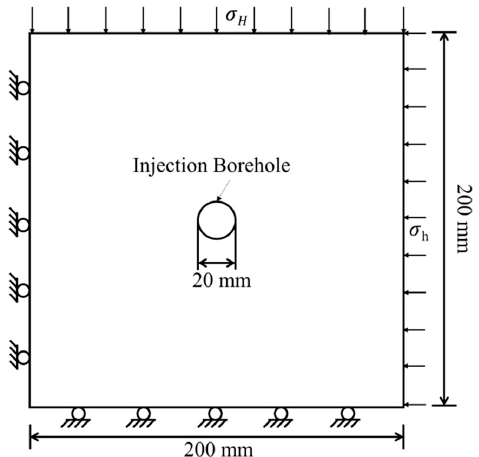
Figure 7. Thegeometryofthemodelwhichisusedinfracturingpropagationtypenumericalsimulationworks. Figure 7. The geometry of the model which is used in fracturing propagation type numerical simulation works. Table 4. Parameters used in the model.